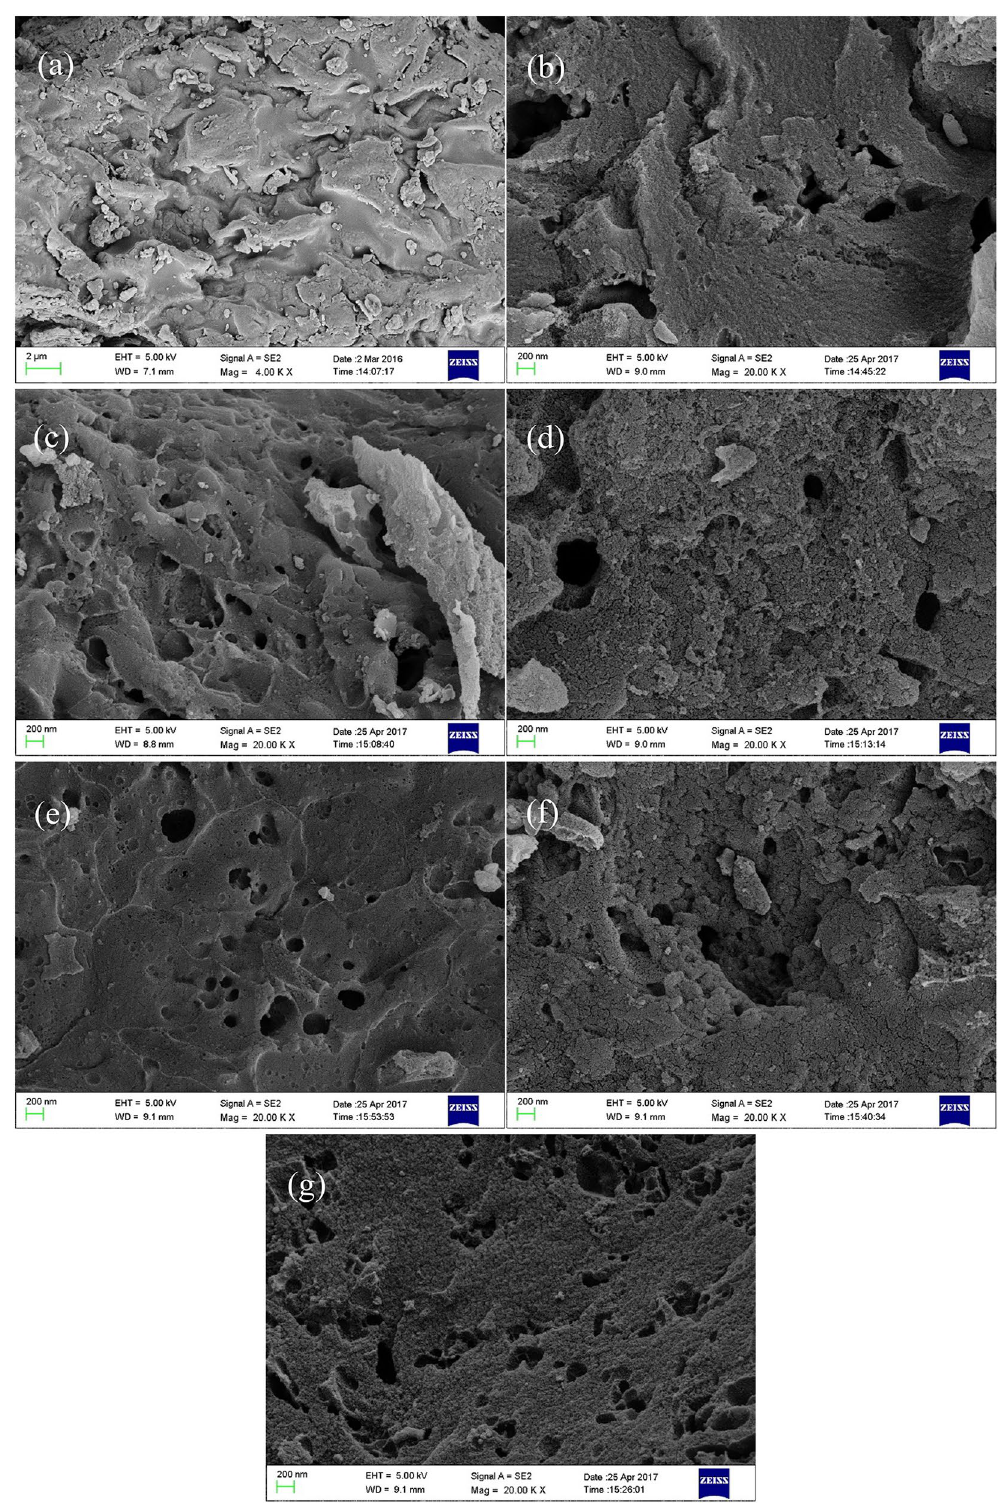
Figure 6. SEM of sargassum and SACs. ( a ): Sargassum; ( b ): AC 16 ; ( c ): AC 2 ; ( d ): AC 13 ; ( e ): AC 3 ; ( f ): AC 12 ; ( g ): AC 14